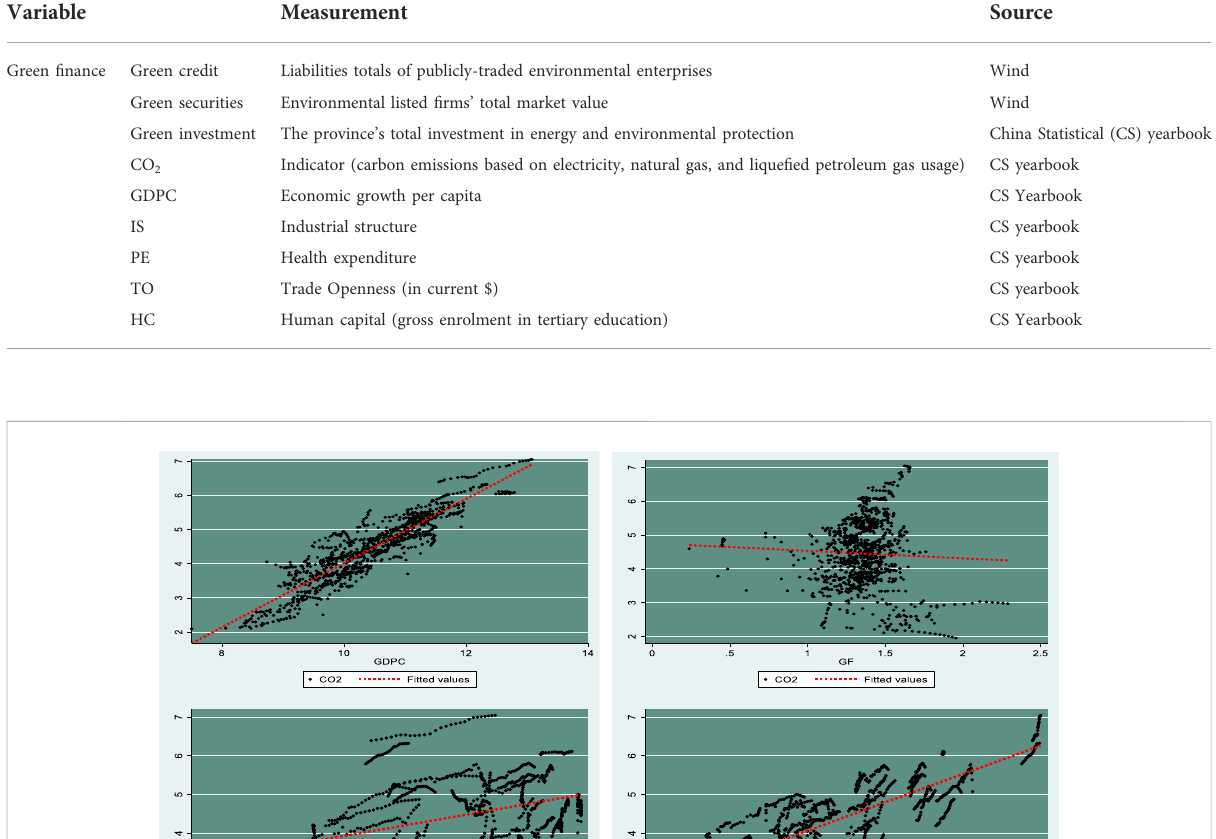
TABLE 1 Description of variables.